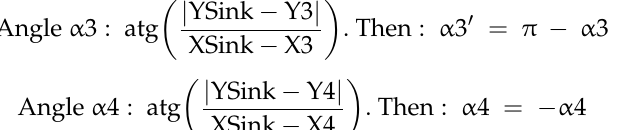
Figure 5. Mobile agent form.